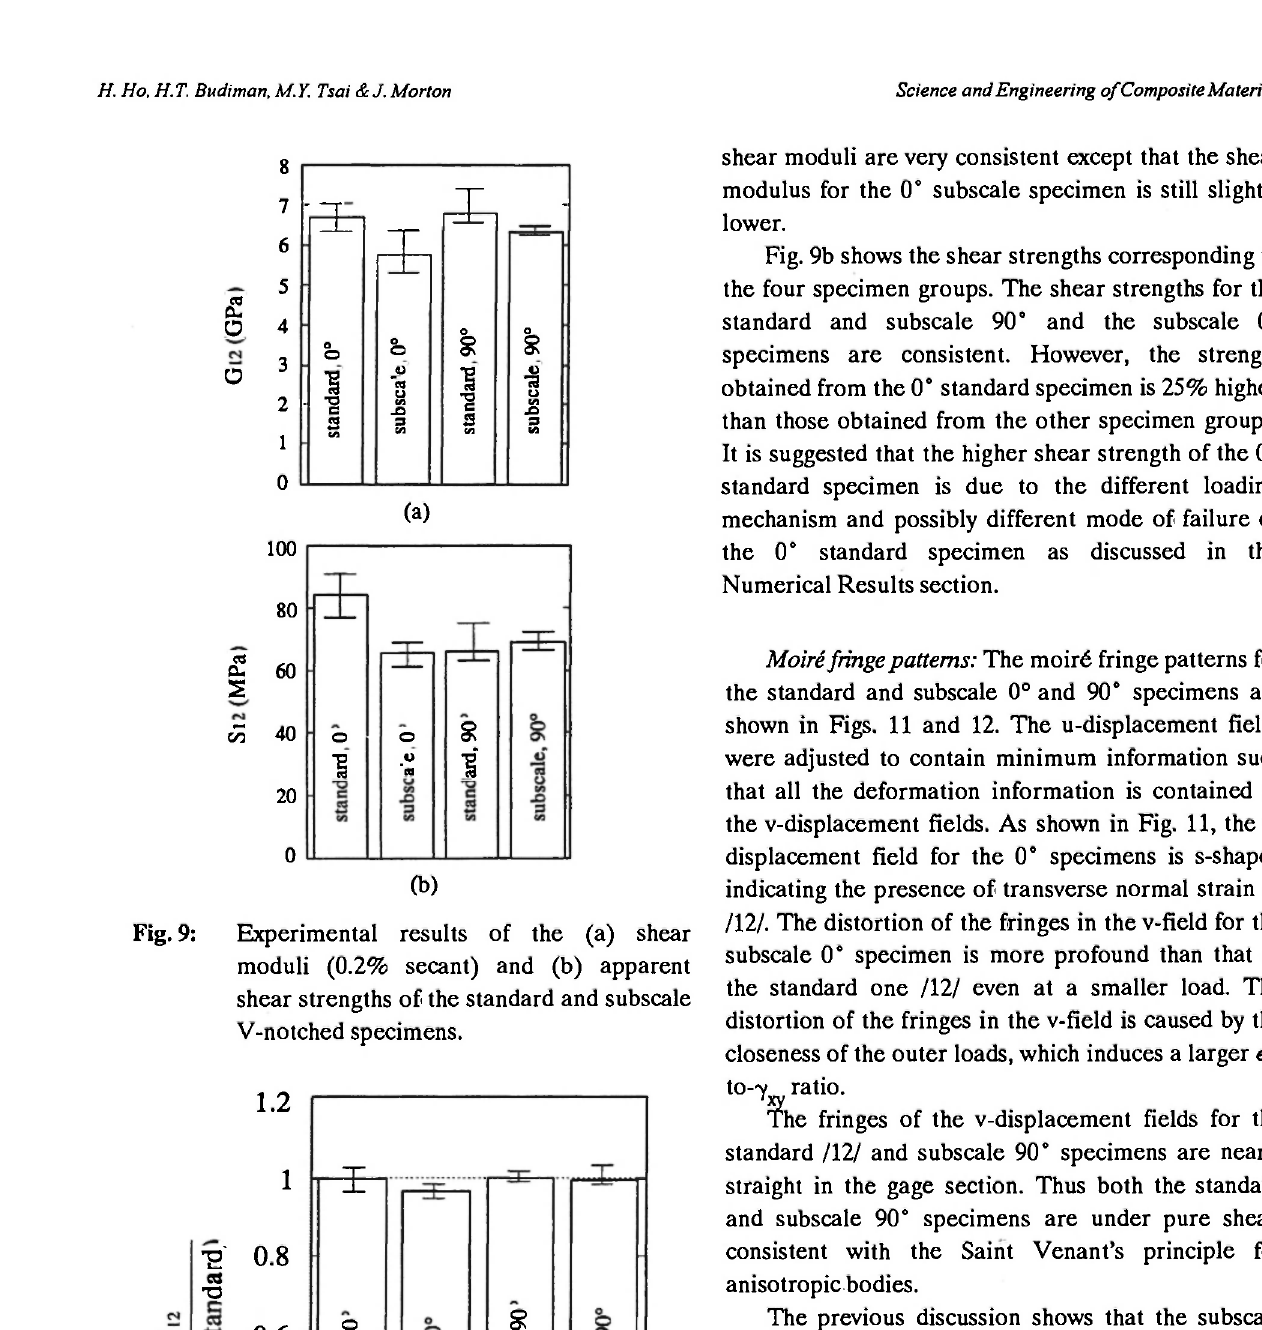
Fig. 10: Effect of reducing the specimen length on the measurement of shear modulus for V- notched specimens - a direct